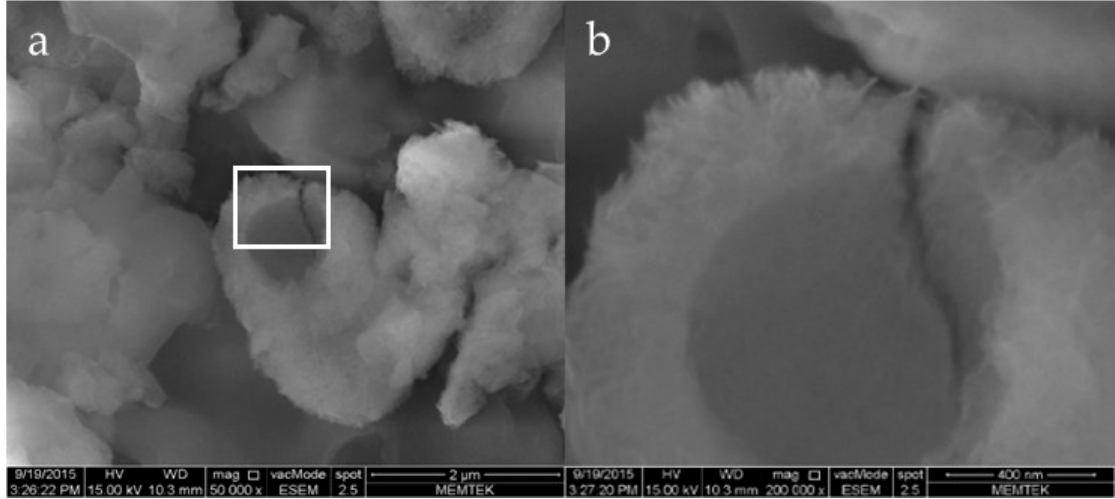
Figure 10. ( a ) Apatite crystal developed in M1 and M2 experiments; and ( b ) a closer view of the squared area in a.